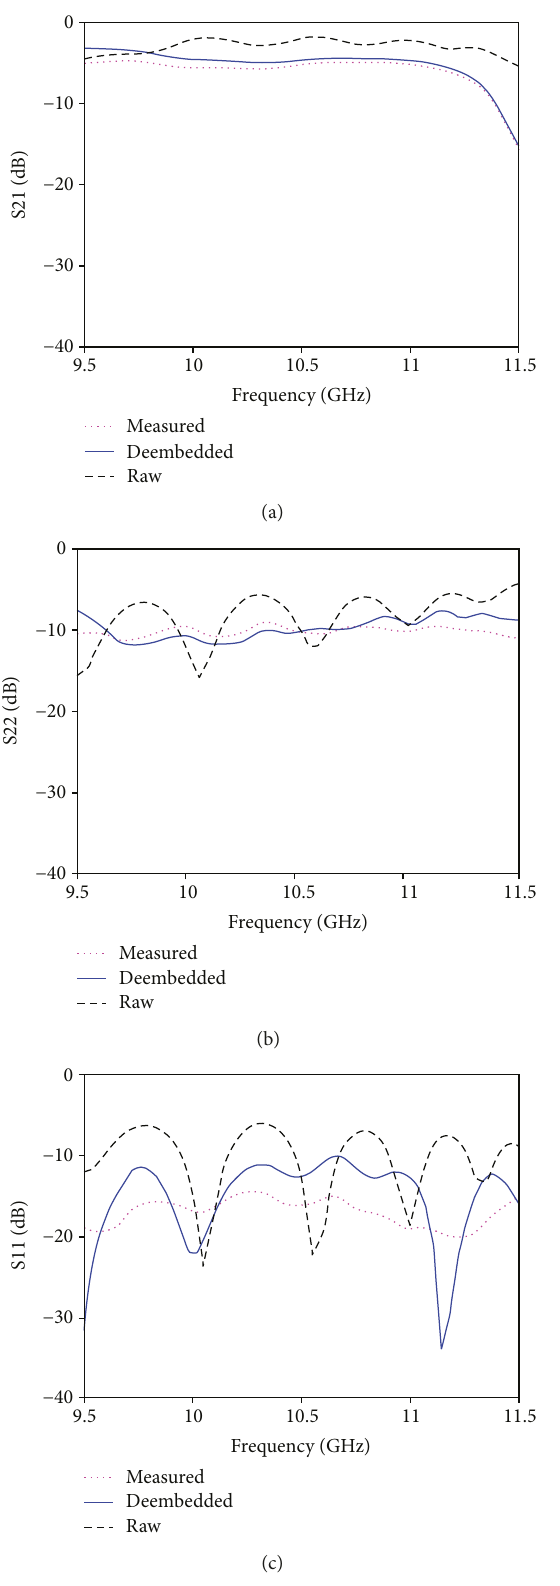
Figure 14: Characteristic S-parameters before and after deembedding of EBG guide with 3 rows and 16 periods. Raw is the simulated result of DUT. (a) S21, (b) S22, and (c) S11.